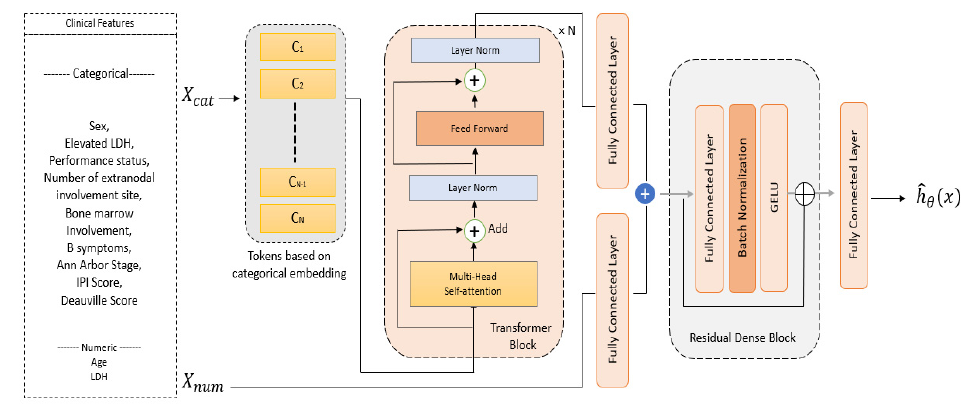
Figure 1. Architecture of the proposed